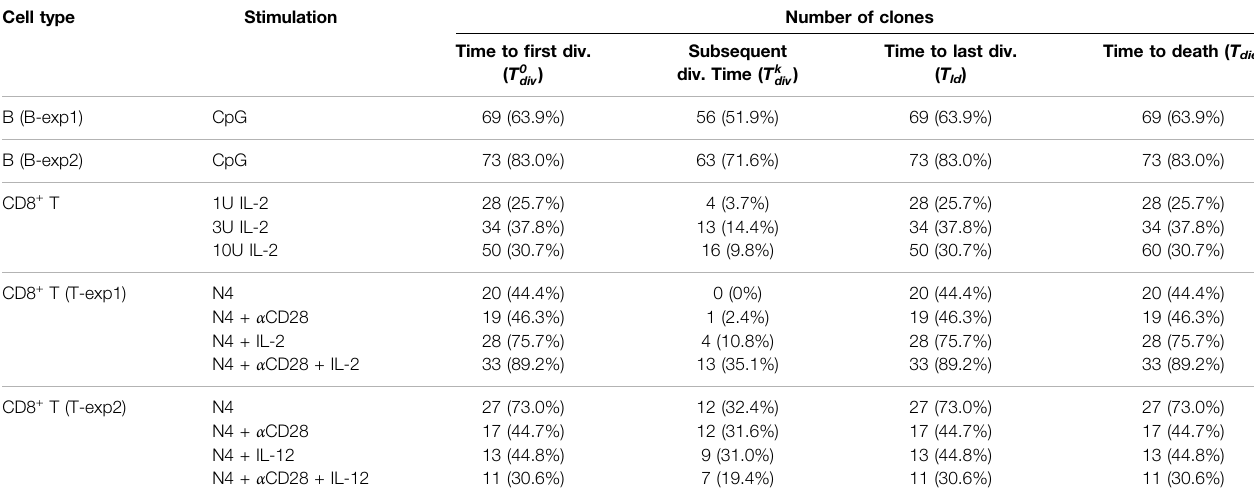
TABLE3| Numberofclonesusedintheanalysisofthe fi lmingdatasets.Thenumberswereobtainedby fi lteringonclonesthathaddividedatleastonceandwhoselastevent was a death event (not a loss or a division). The percentage is expressed in relation to the total number of clones in the experiment. For a given cell type and stimulation, the values of each Cyton2 variable were extracted for the statistical